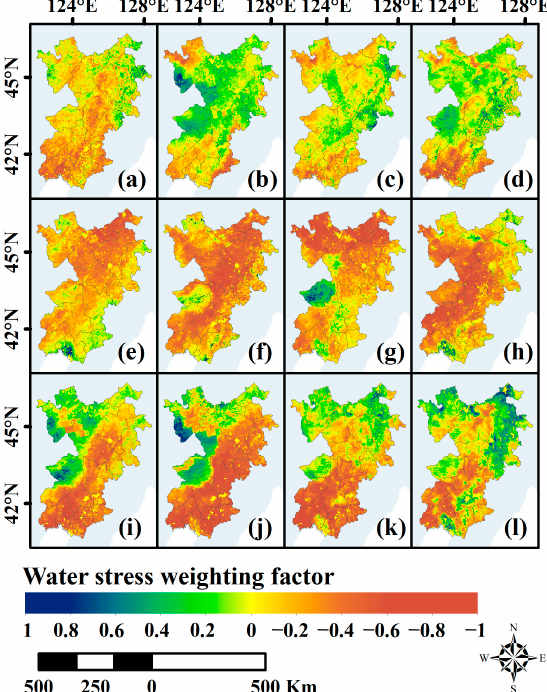
Figure 9. Water stress weight coefficients for the three growth stages of maize: ( a – d ) water stress